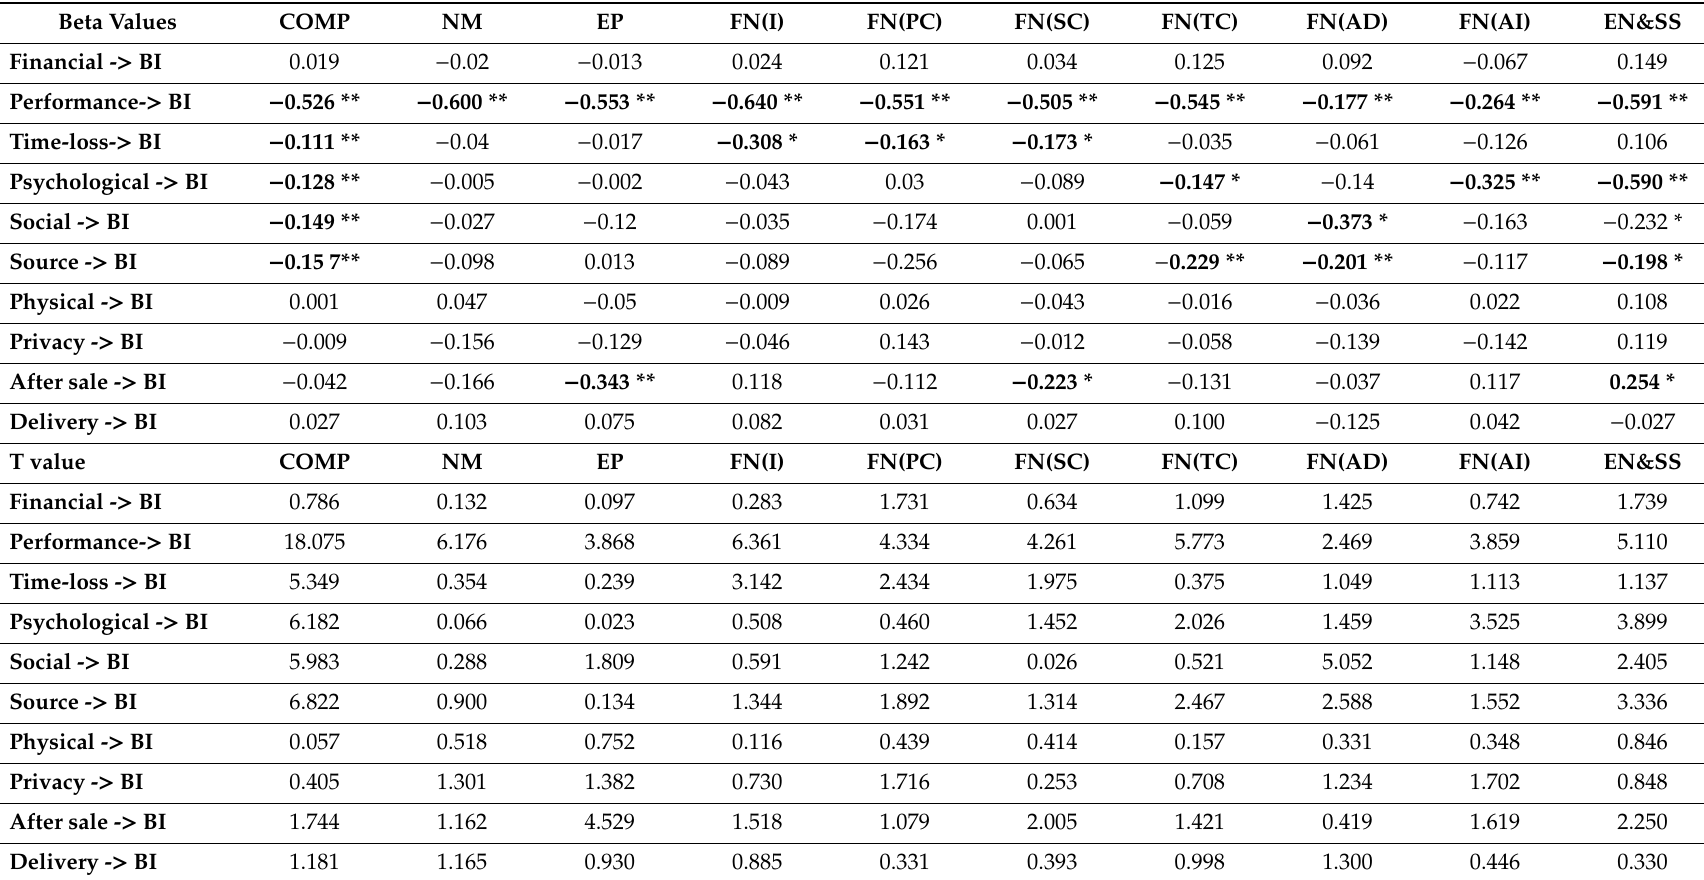
Table 4. Partial least squares structural equation modelling (PLS-SEM)